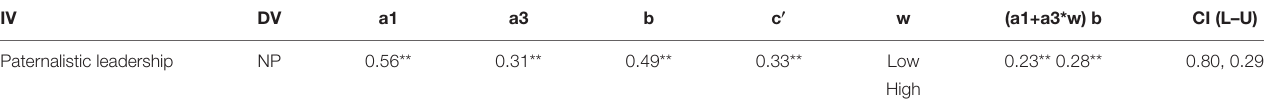
TABLE 4 | Regression for testing power distance moderation effect for self-efficacy and nurses’ performance.